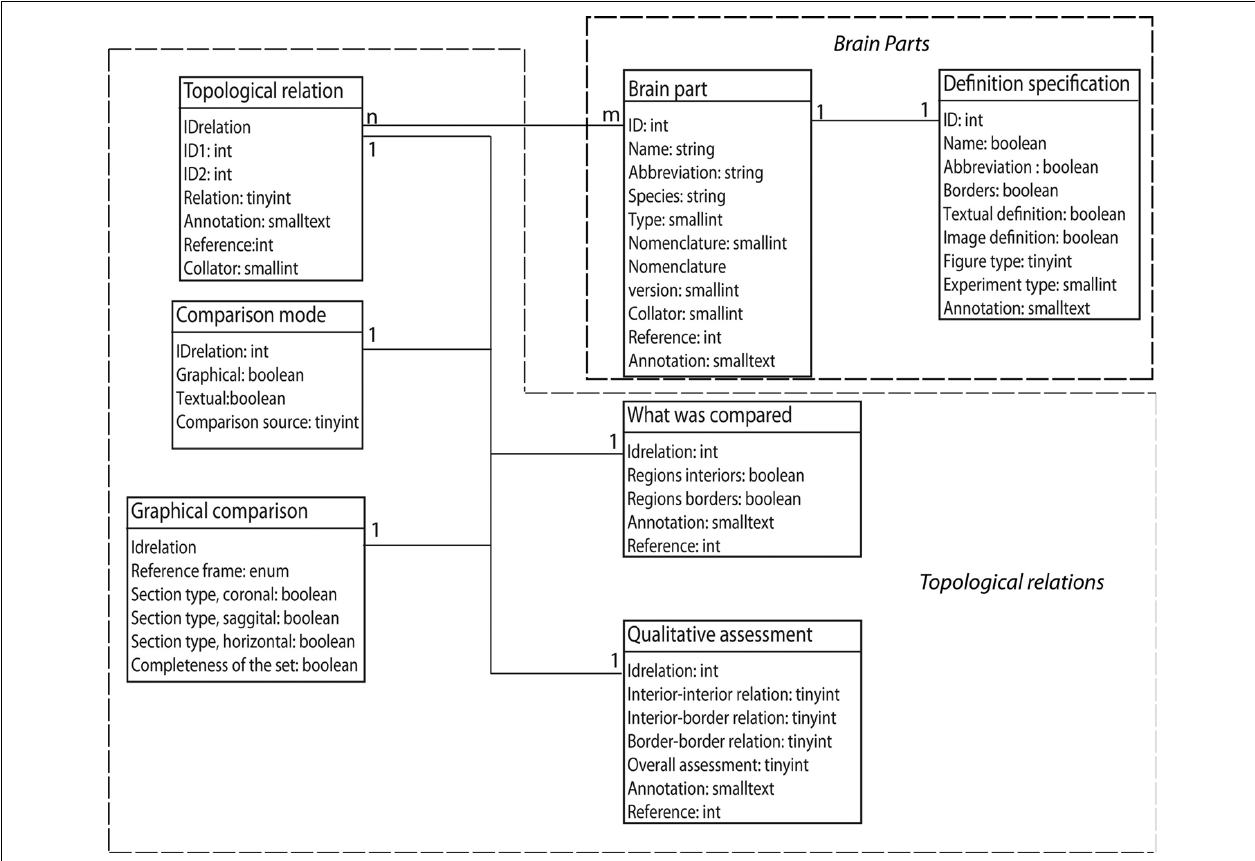
FIGURE 1 | The ER structure of the new Topological Relations module of BAMS. The Brain Parts and the Topological Relations modules are shown in dotted